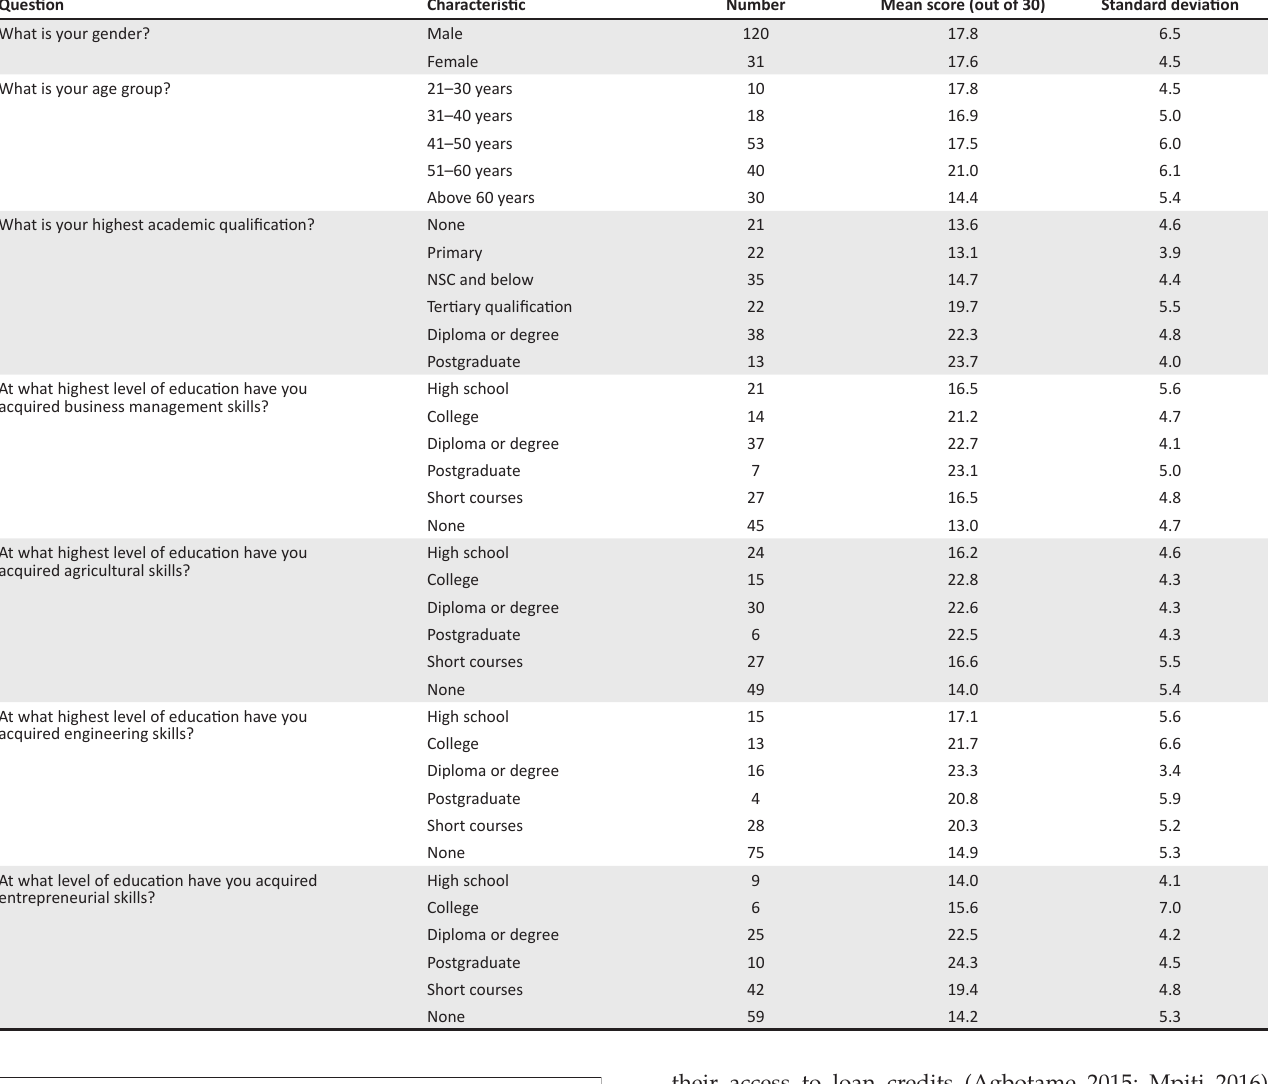
TABLE 1: Demographic characteristics of owners and/or